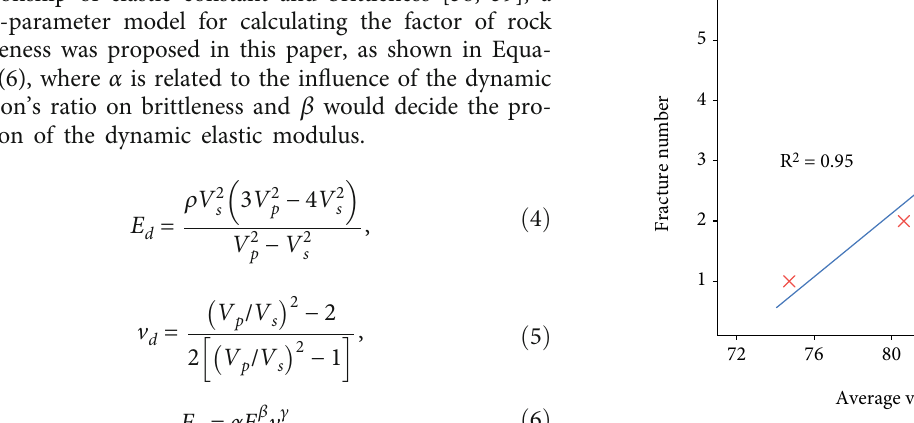
Figure 9: The relationship between B